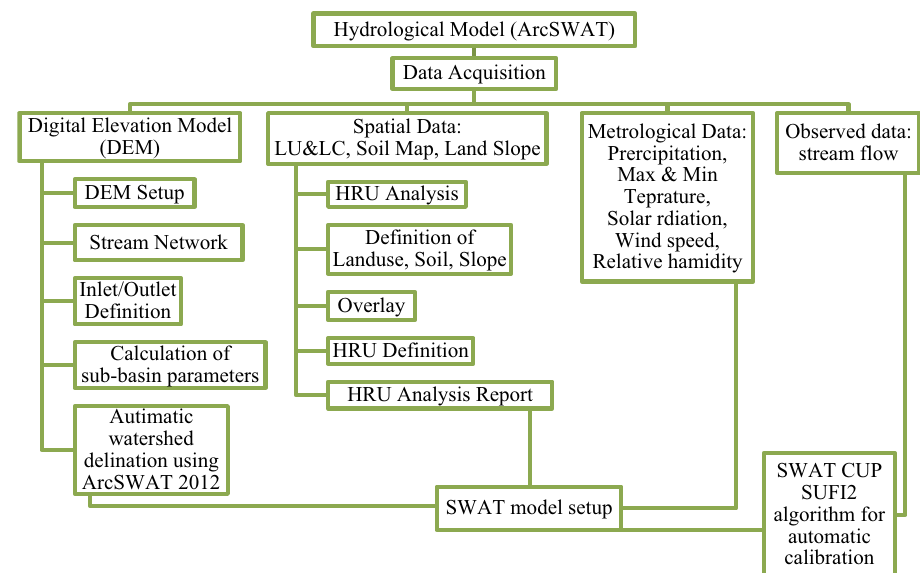
Fig. 11 Methodological framework adopted for SWAT Model of Hemren dam reservoir catchment area